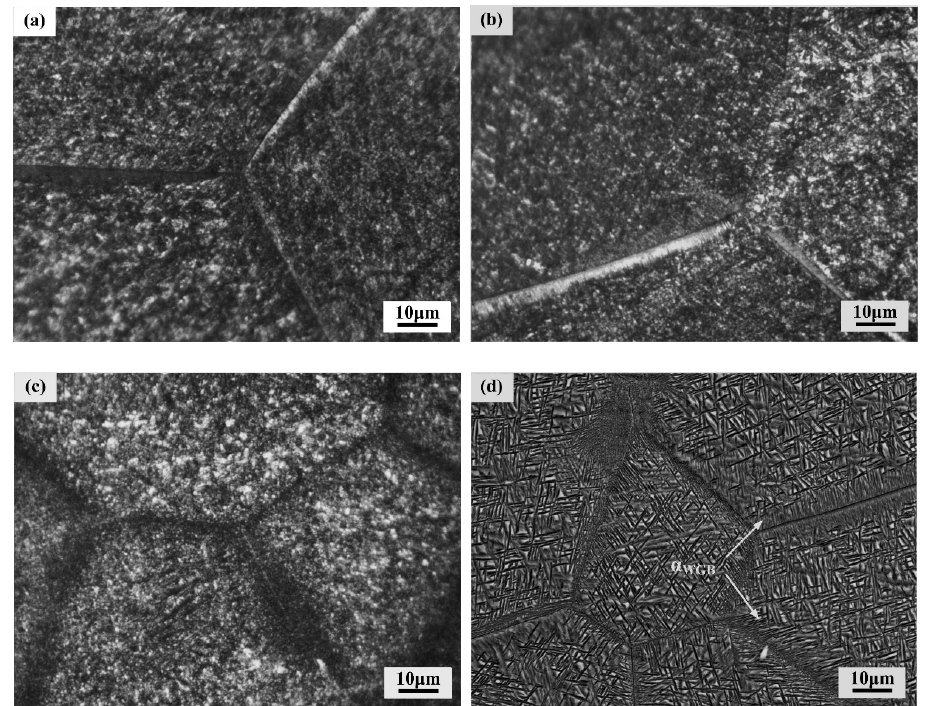
Figure 4. Microstructure of the alloys aged at ( a ) 480 °C; ( b ) 520 °C; ( c ) 560 °C; ( d ) 600 °C for 4 h.